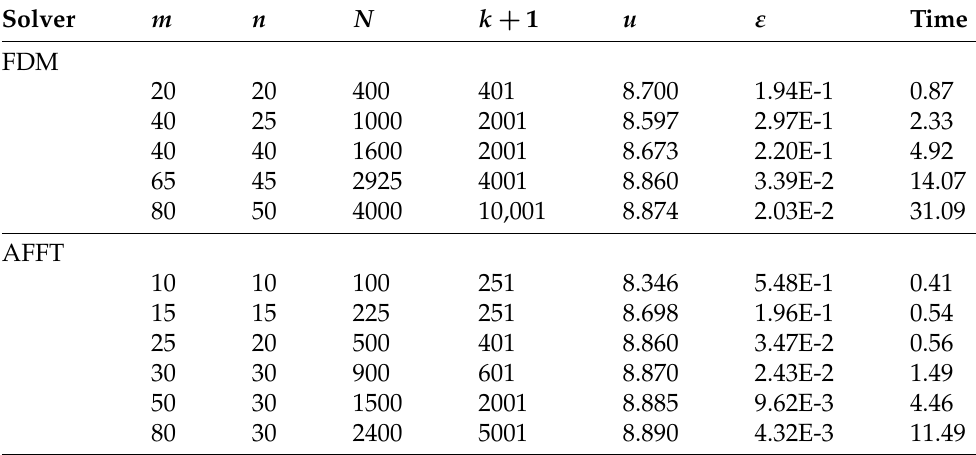
Table 1. Numerical results for Example